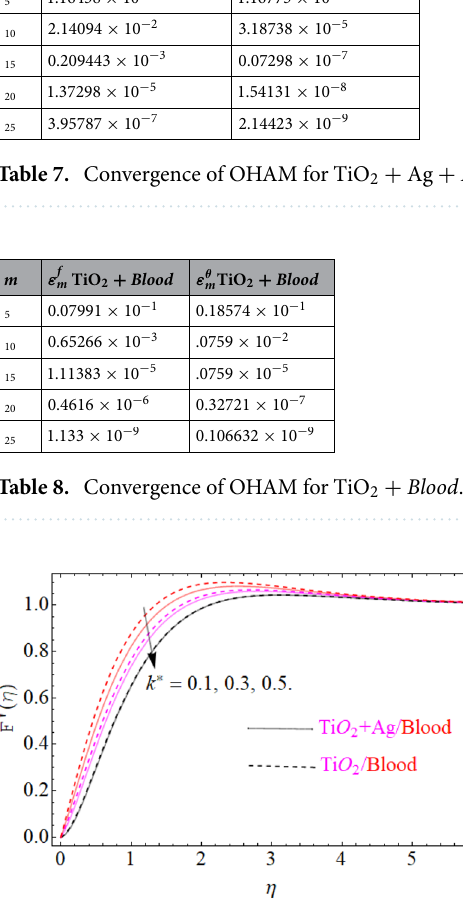
Figure 2. Under the influence of k ∗ (couple stress parameter), F ′ (η) .